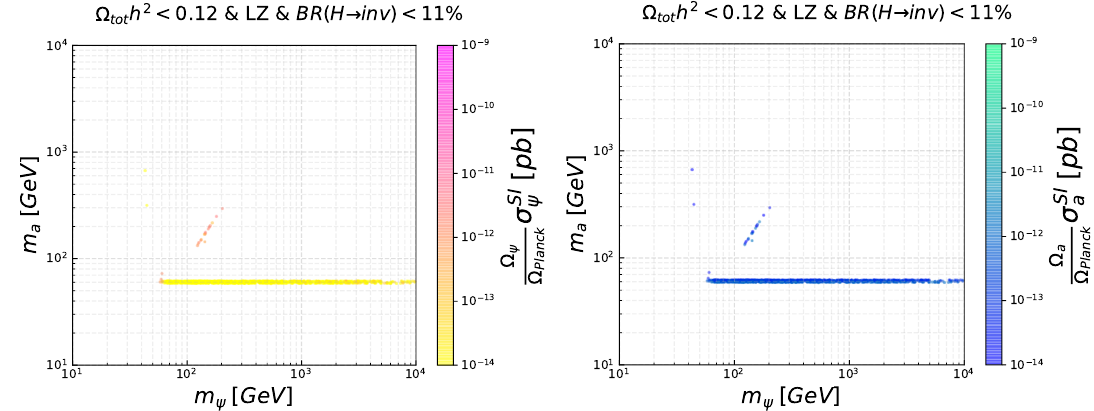
Figure 13. Direct detection cross-sections (scaled by relevant relic abundance fraction) for the two DM species plotted in the mass plane, with constraints applied from future experiment LZ [7]. Note that small values below the range are shown with colour corresponding to the smallest value.